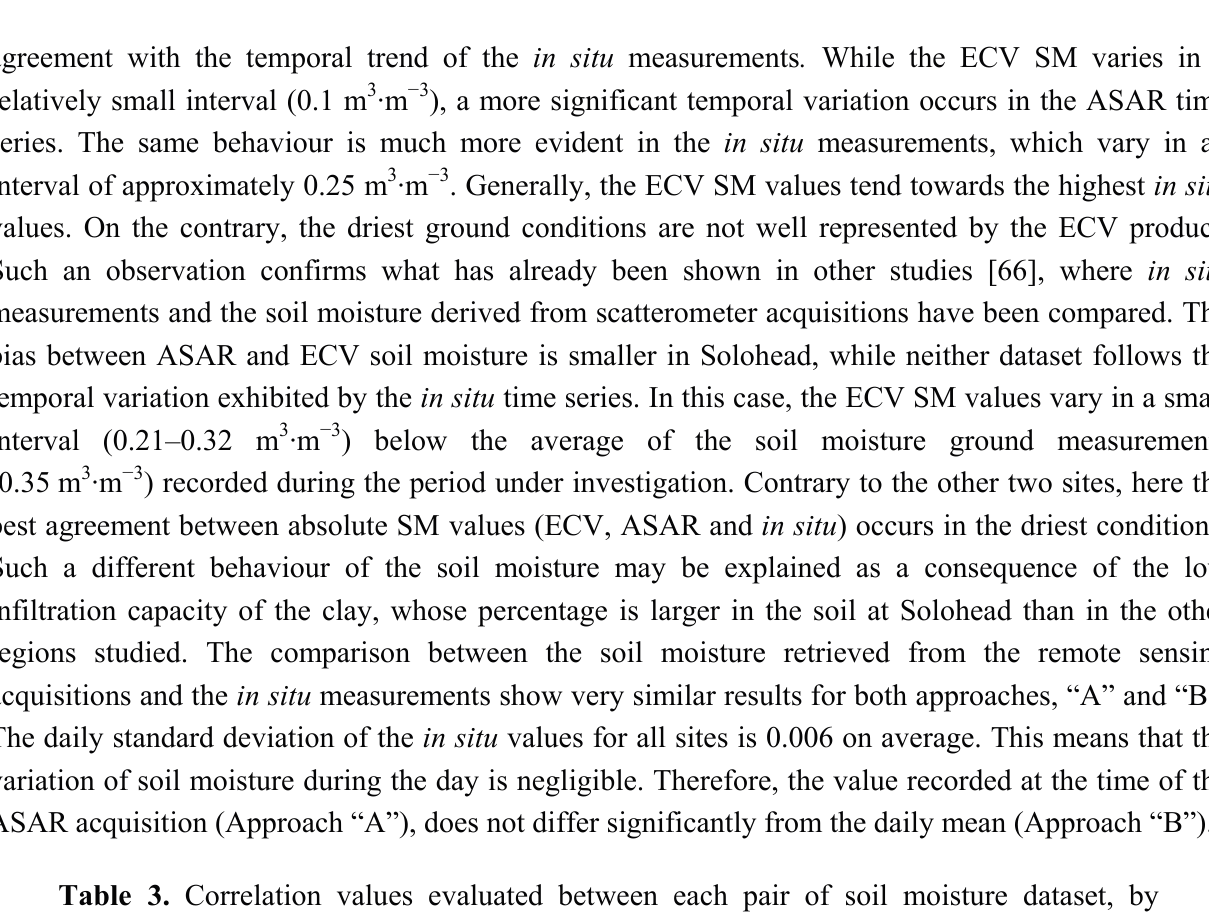
Table 3. Correlation values evaluated between each pair of soil moisture dataset, by adopting Approach “B”. No significant difference has been observed between the Approaches “A” and “B”. Because of the very small SM daily variation, the use of both ascending and descending ASAR SM data or their average leads to similar results.